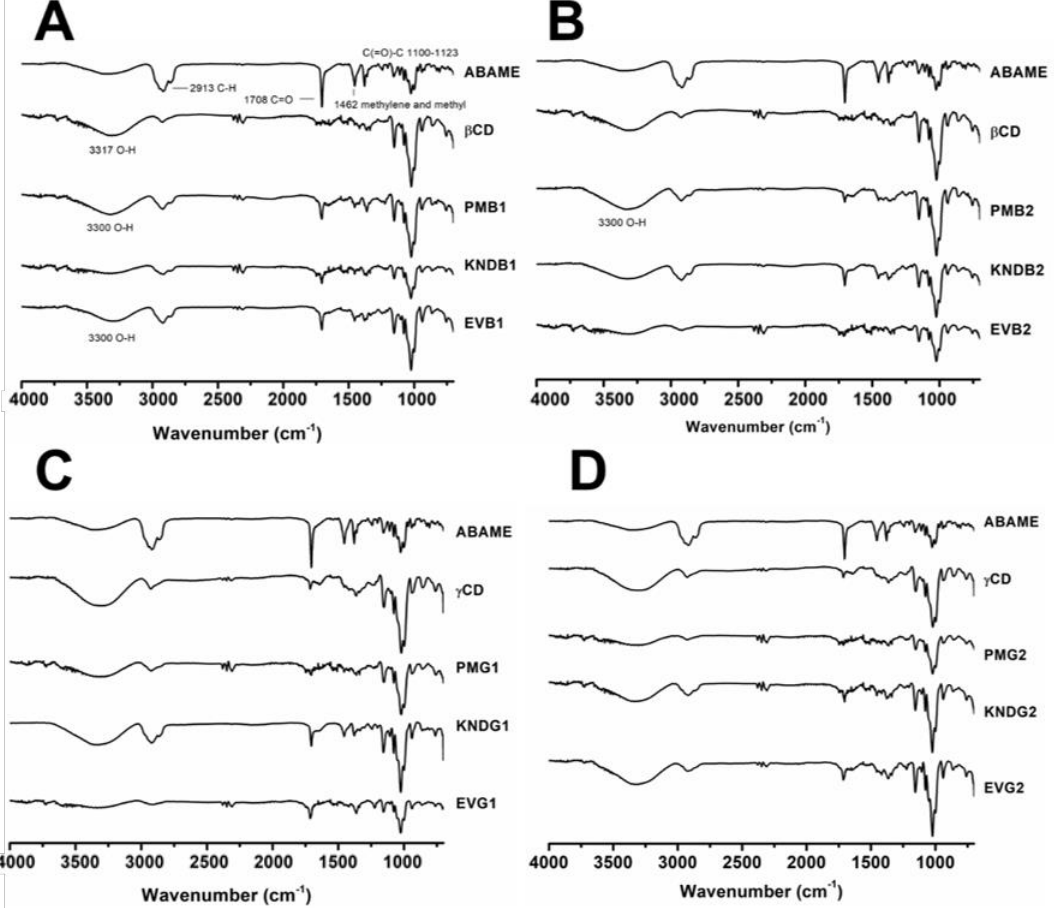
Figure 6. FTIR-ATR spectra of individual compounds, namely α , β -amyrenone (ABAME), β -cyclodextrin ( β CD) and γ - cyclodextrin ( γ CD), as well as inclusion complexes (ICs). ICs prepared with ABAME and β CD at 1:1 ( A ) and 2:1 ( B ) molar ratios using physical mixture (PMB1 and PMB2), kneading (KNDB1 and KNDB2), and rotary evaporation (EVB1 and EVB2), respectively. ICs prepared with ABAME and γ CD at 1:1 ( C ) and 2:1 ( D ) molar ratios using physical mixture (PMG1 and PMG2), kneading (KNDG1 and KNDG2), and rotary evaporation (EVG1 and EVG2),